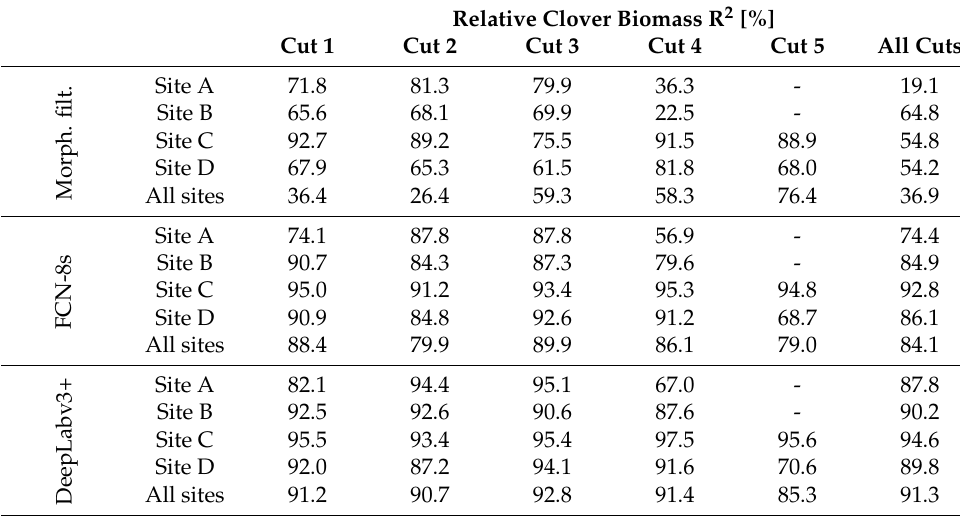
Table 5. Detailed comparison of the DeepLabv3+ST model with the FCN-8s model from Skovsen et al. [16] and the extended morphological filtering from Mortensen et al. [9] on the 915 biomass samples. The relative clover content prediction is evaluated using coefficient of determina- tion between the detected clover fraction of canopy cover and relative clover content in the biomass, decomposed into individual experimental sites and seasonal cuts. The generalizability of each method can be observed by the drop in predictive performance moving from individual acquisition dates to aggregations across seasonal cuts and experimental